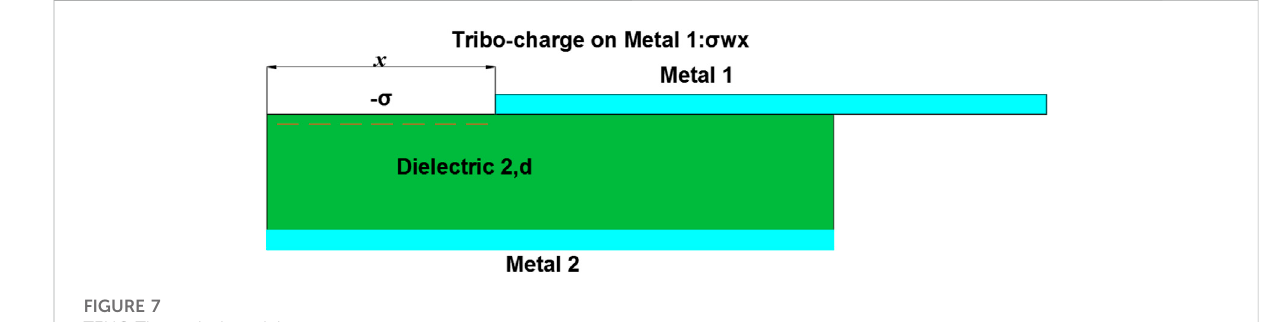
FIGURE 6 TENG simulation potential distribution.